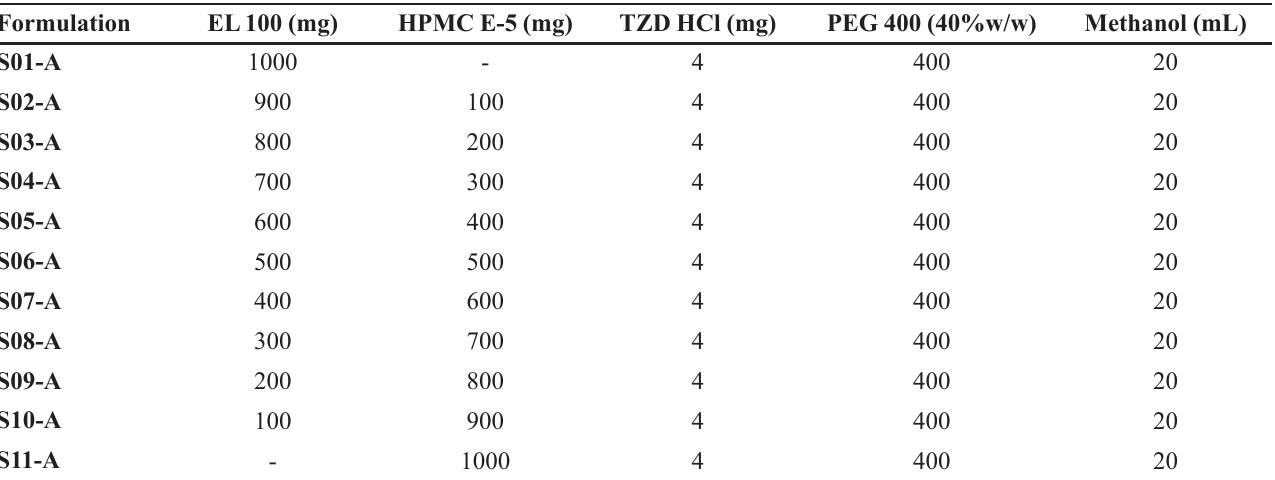
TABLE I - Composition of different transdermal formulations containing TZD HCl without permeation enhancers Formulation